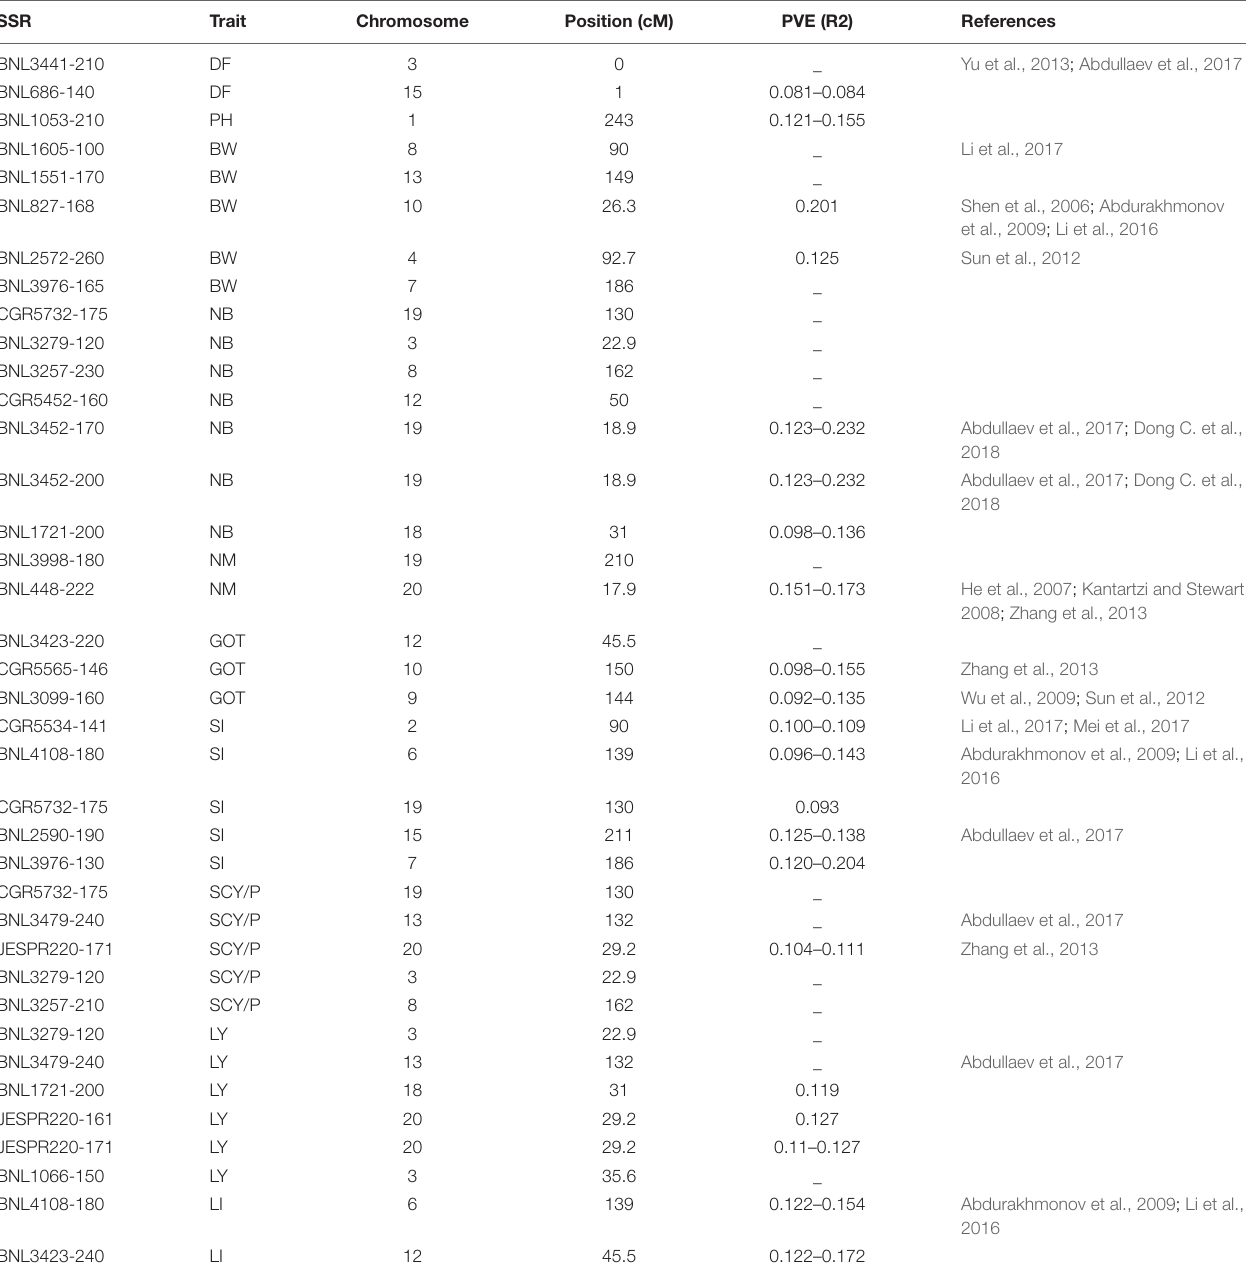
TABLE 3 | List of significant marker–trait associations which were common to at least two